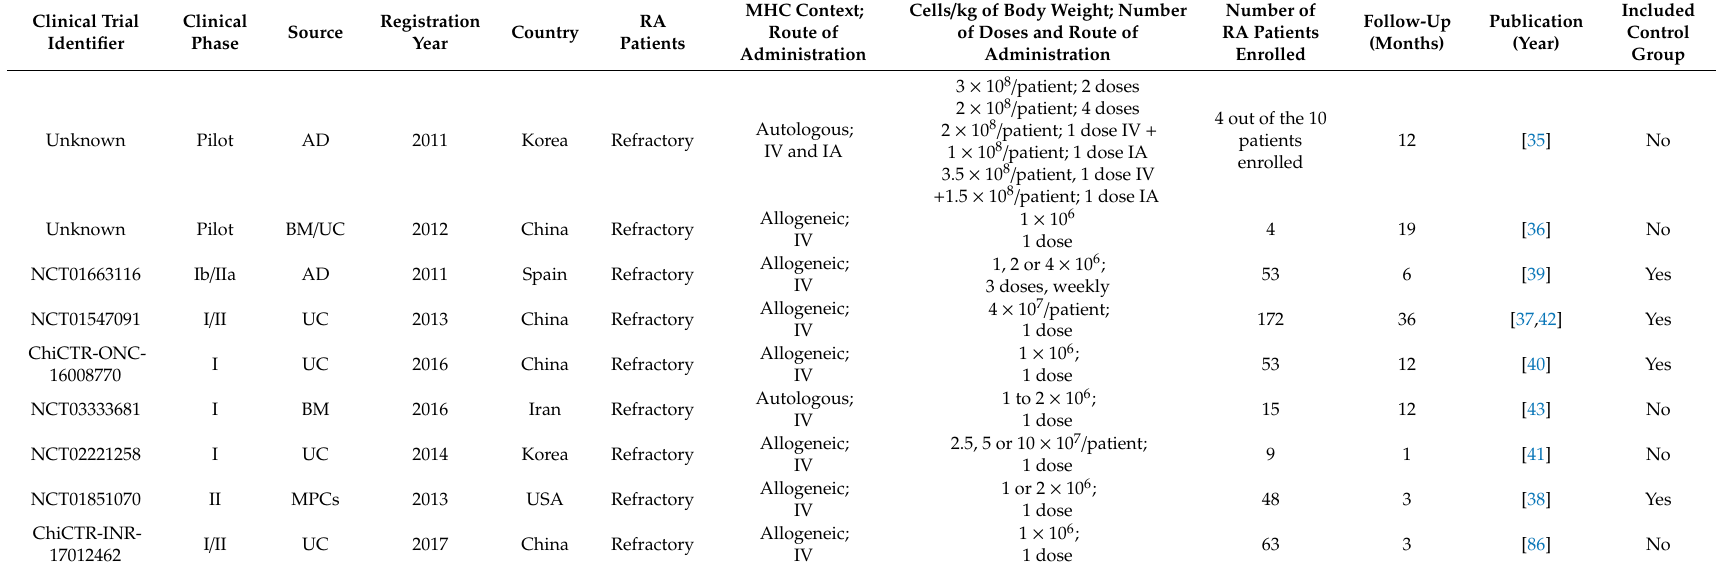
Table 2. Summary of completed rheumatoid arthritis clinical trials with MSC